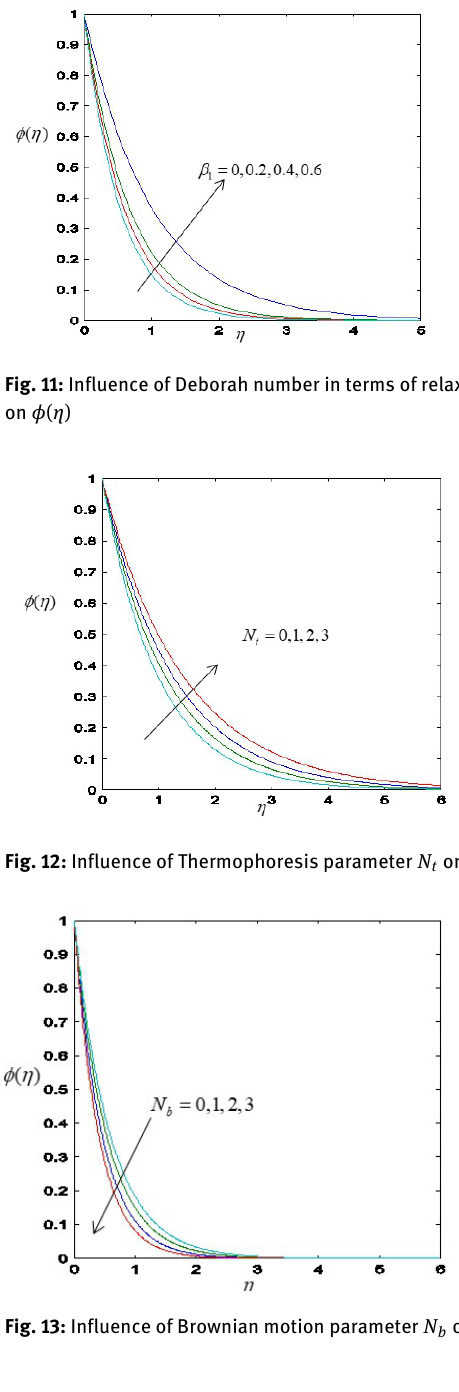
pact of Deborah number β on the nanoparticles concen- 1 tration profile ϕ ( η ). Increasing values of Deborah num- ber β repots enrichment in concentration profile. Fig. 12 1